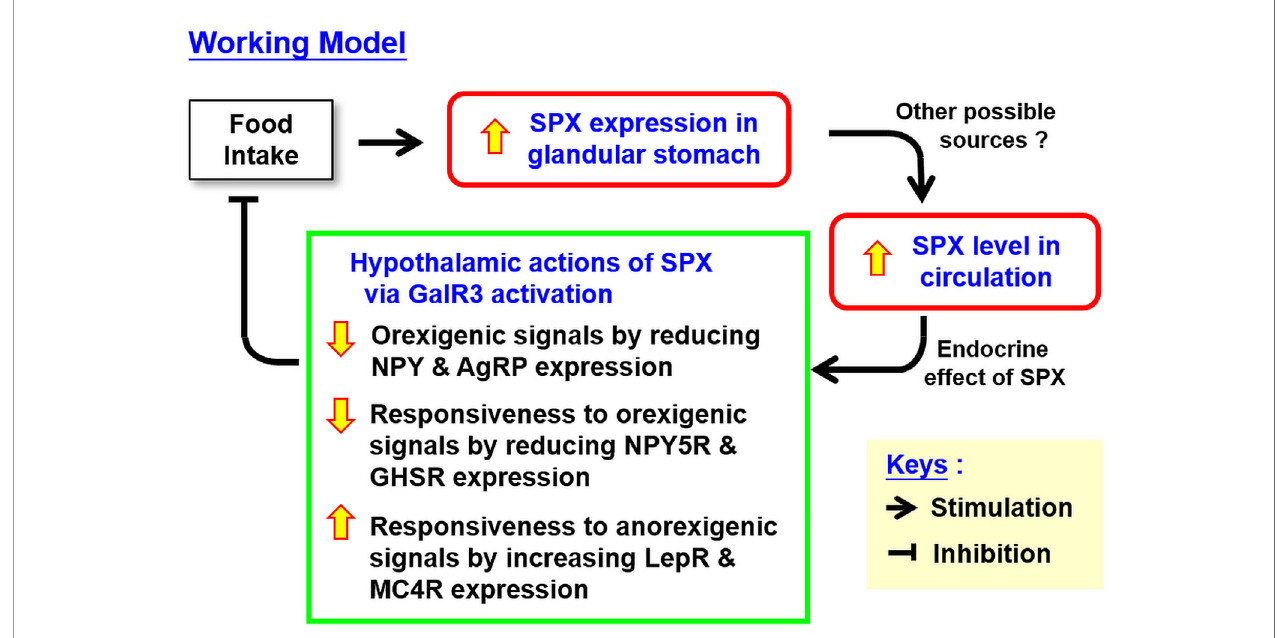
FIGURE 9 | Working model for the role of SPX as a satiety factor in the mouse via regulatory actions within the hypothalamus. In the mouse, food intake can induce SPX gene expression in glandular stomach and the subsequent rise in SPX production may contribute to the elevation of SPX signal in blood observed after feeding. The circulating SPX by acting in an endocrine manner can initiate a feedback inhibition on food intake by central actions acting in the hypothalamus. In this case, hypothalamic expression of orexigenic factors (including NPY and AgRP) and receptors for orexigenic signals (including NPY5R and GHSR) can be suppressed by SPX with concurrent up-regulation of the receptors for anorexigenic signals (including LepR and MC4R). The drops in orexigenic signals together with the differential regulation of hypothalamic responsiveness to orexigenic and anorexigenic factors probably can lead to feeding inhibition in the mouse. In the model proposed, we do not exclude the possibility that the postprandial rise of SPX in circulation may also be originated from other tissues in addition to the glandular